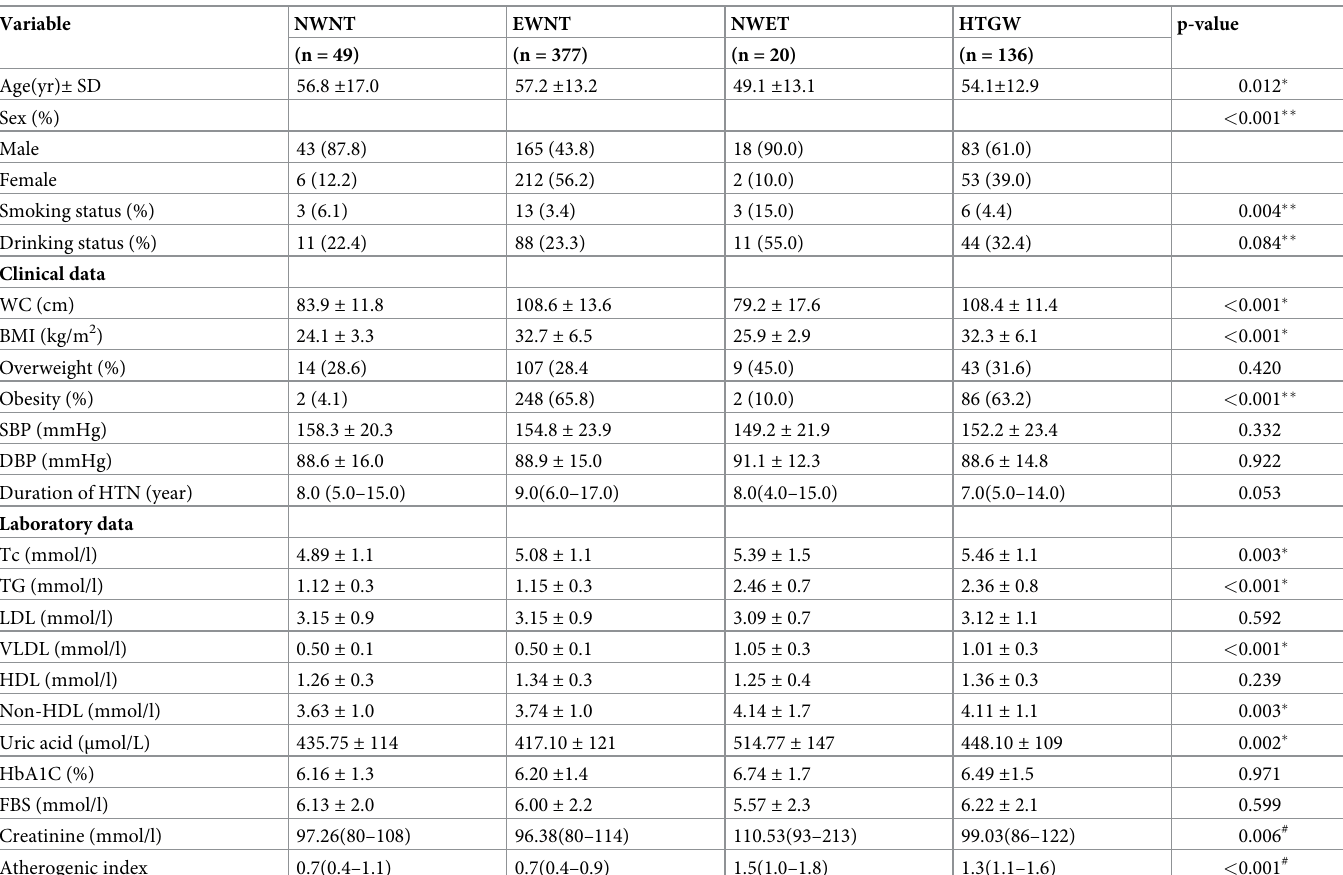
Table 2. General characteristics of the hypertensive triglyceridemic-waist